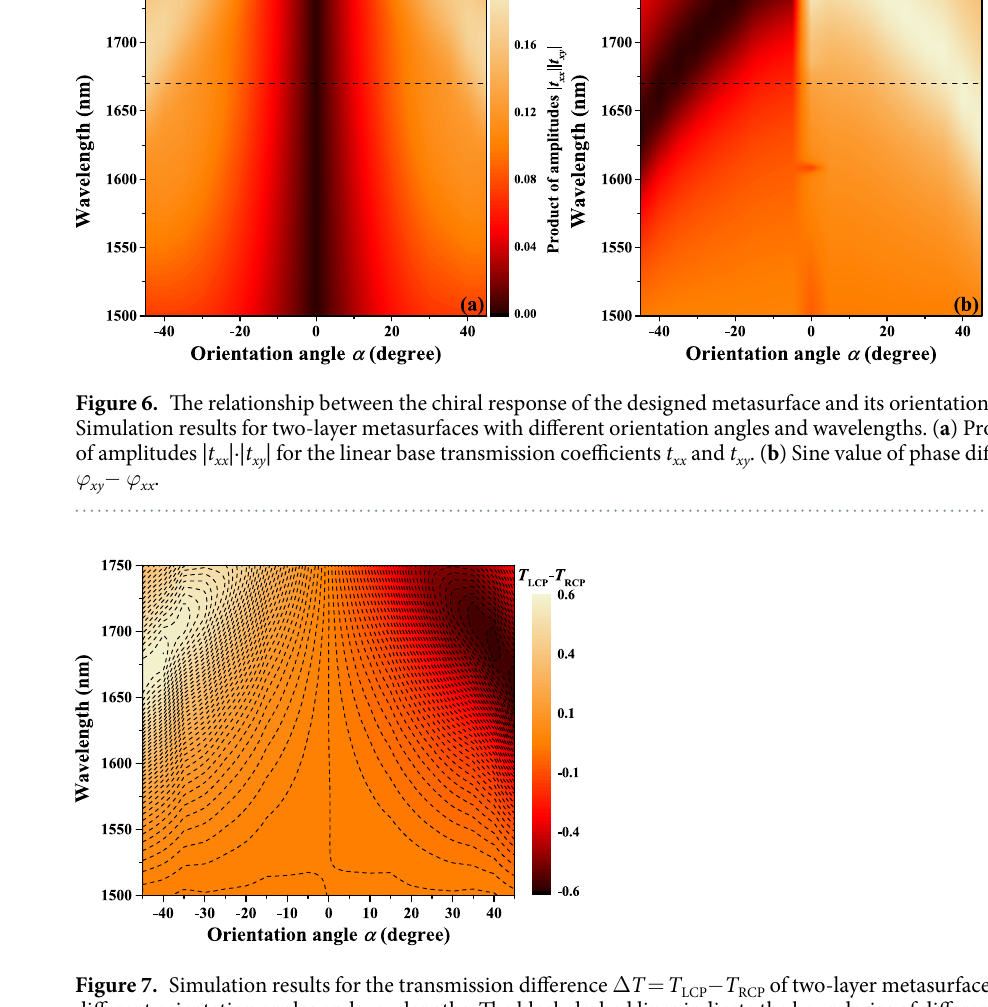
Figure 7. Simulation results for the transmission difference Δ T = T LCP − T RCP of two-layer metasurfaces with different orientation angles and wavelengths. The black dashed lines indicate the boundaries of different values of Δ T